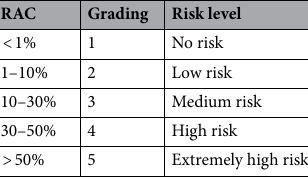
Table 3. Classification of risk assessment code.